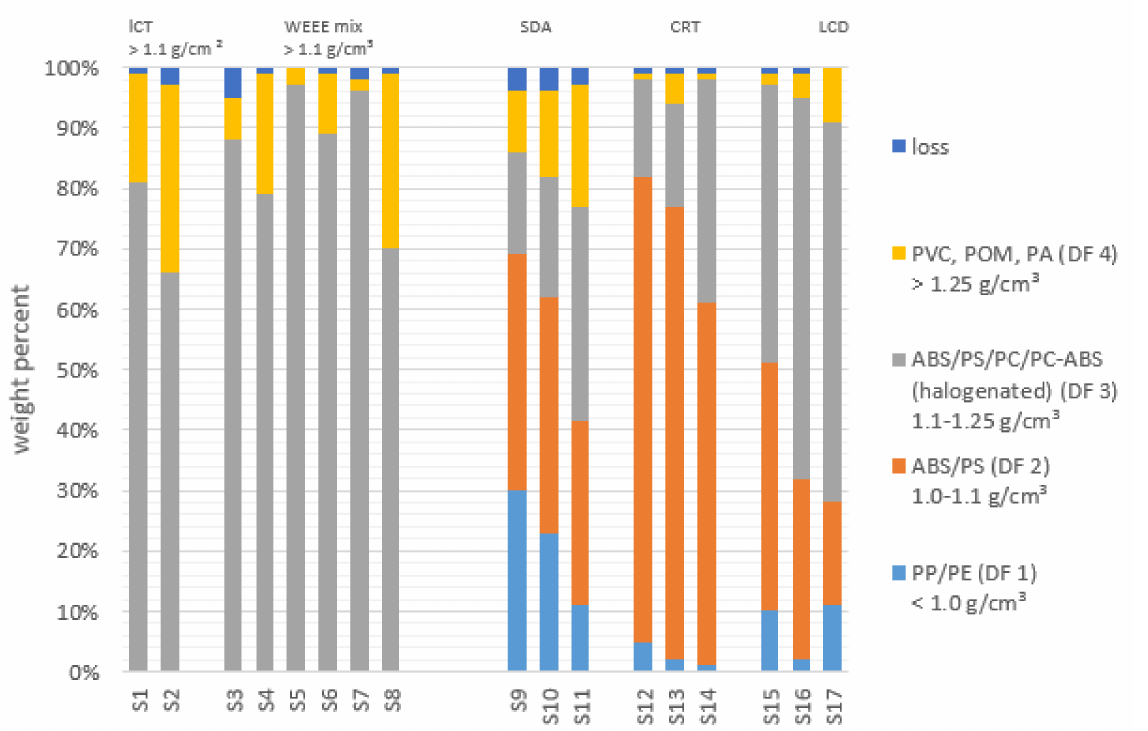
Figure 1. Overview of the density distributions from the different fractions (S =